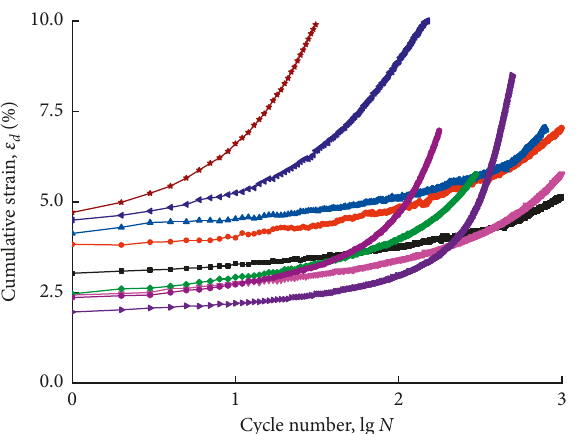
Figure 5: Loading process.